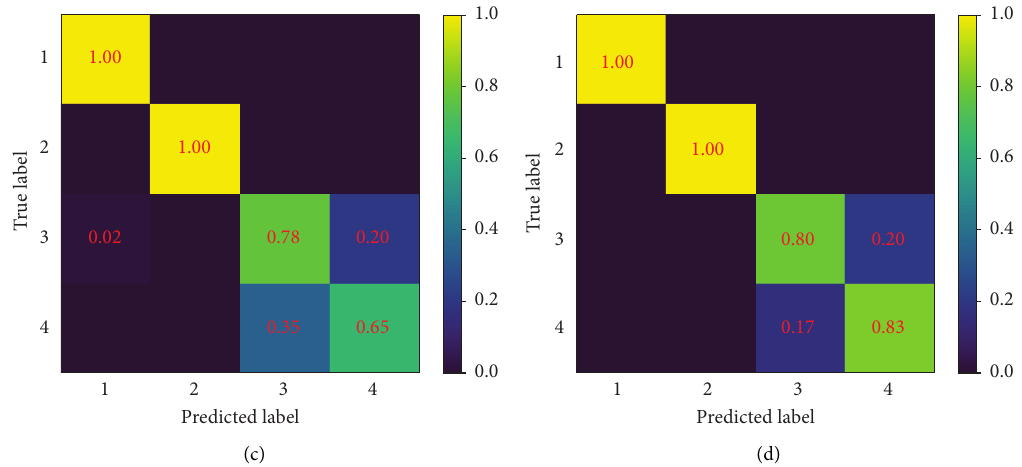
Figure 7: Confusion matrix of four methods. (a) PSO-LSSVM. (b) GA-LSSVM. (c) WOA-LSSVM. (d) IWOA-LSSVM.